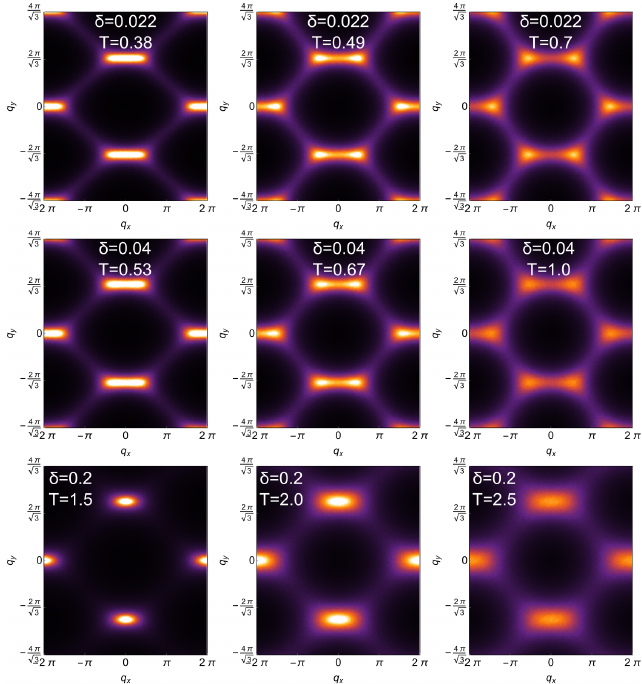
Figure 7: The structure factor S ( q ) [ Eq. 4 ] in the anisotropic, dipolar, triangular-lattice, Ising antifer- romagnet. Simulations are run for hexagonal clusters with L = 48. (Top row) At δ = δ tri = 0.022 there is a tricritical point at T = T tri = 0.343, and above this tricritical point there is a broad maxima in S ( q ) , showing that there are significant fluctuations in the string density, n string . Increasing the temperature leads to a sharper maximum at q string , showing a reduction in the variance of n string . (Middle row) At δ = 0.04 there are peaks in S ( q ) at q string that coexist close to the phase transition with an additional peak at q stripe . At higher temperatures the peaks at q stripe are suppressed, leaving the peaks at q string more visible. (Bottom row) At large values of δ (here δ = 0.2) the spin liquid region is absent, and S ( q ) is peaked at q stripe , displaying the usual behaviour associated with a second-order